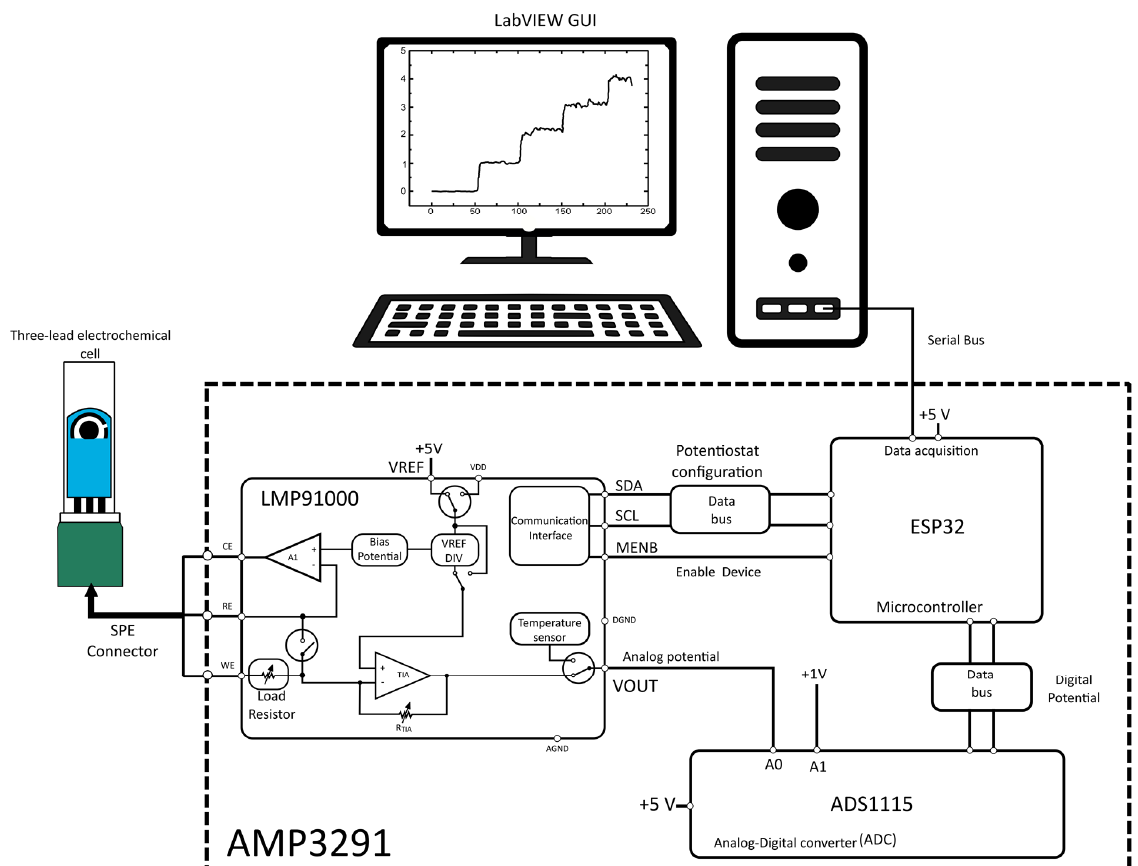
Figure 2. Schematic representation of the custom AMP3291 equipment.